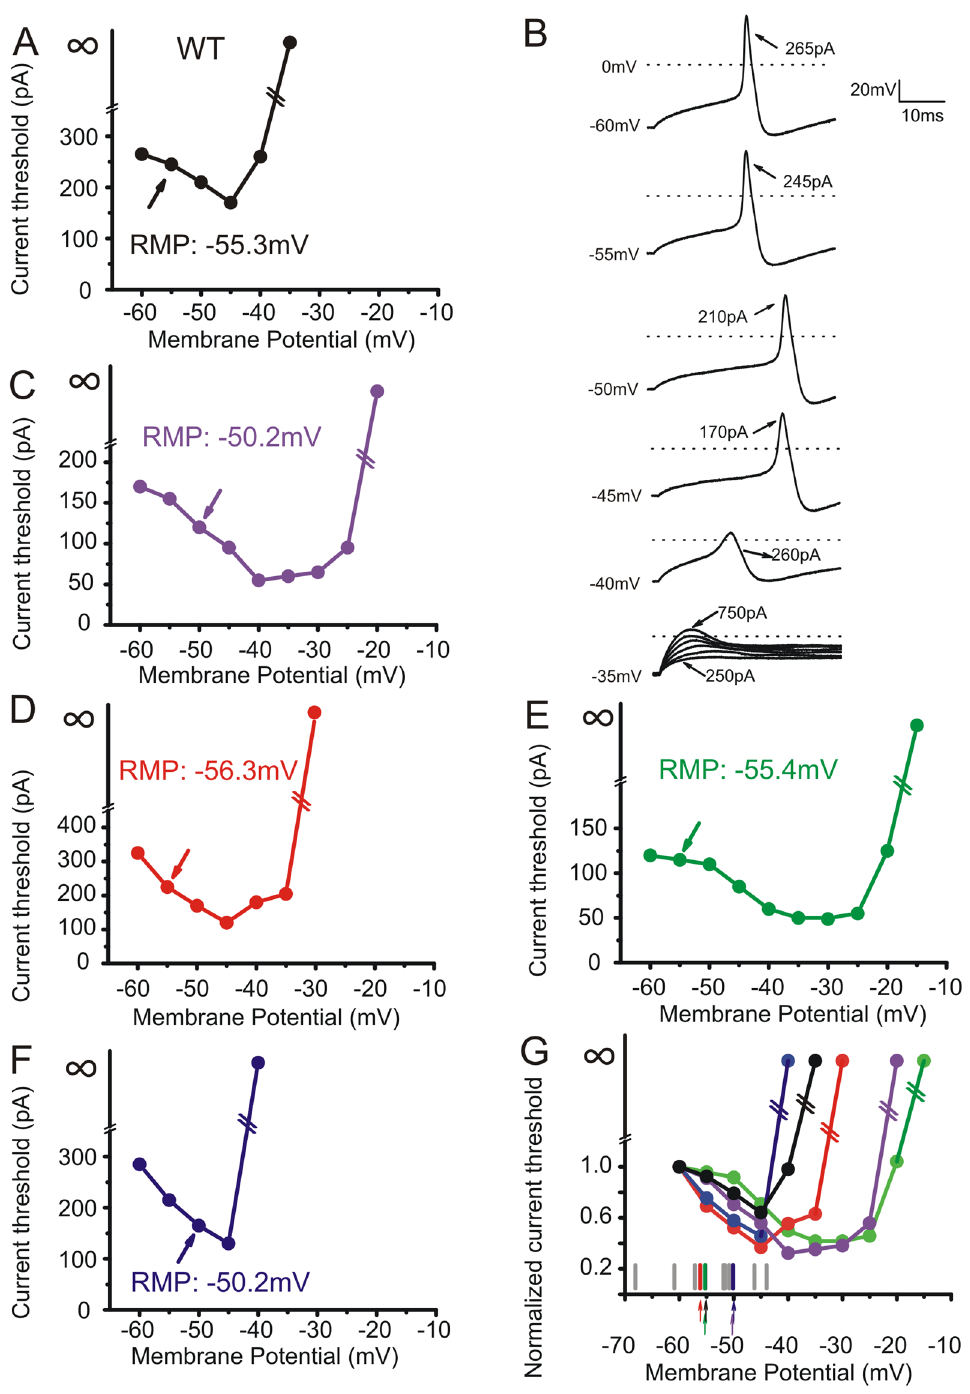
Figure 4. Depolarization of RMP causes biphasic changes in current threshold in DRG neurons expressing WT hNa and membrane potential is U-shaped in five individual cells ( A , C – F ). Note that, for each cell, the bottom of the curve is minimal current threshold. ( B ) Representative traces from the cell illustrated in ( A ) at holding potentials indicated to the left. ( G ) Superimposition of curves from five cells expressing WT, with current threshold normalized to the value at holding potential of − 60 mV. The distribution of RMPs in a total of 16 cells is illustrated under the curves. Arrows with matching colors indicate RMPs from representative cells shown in ( A , C – F